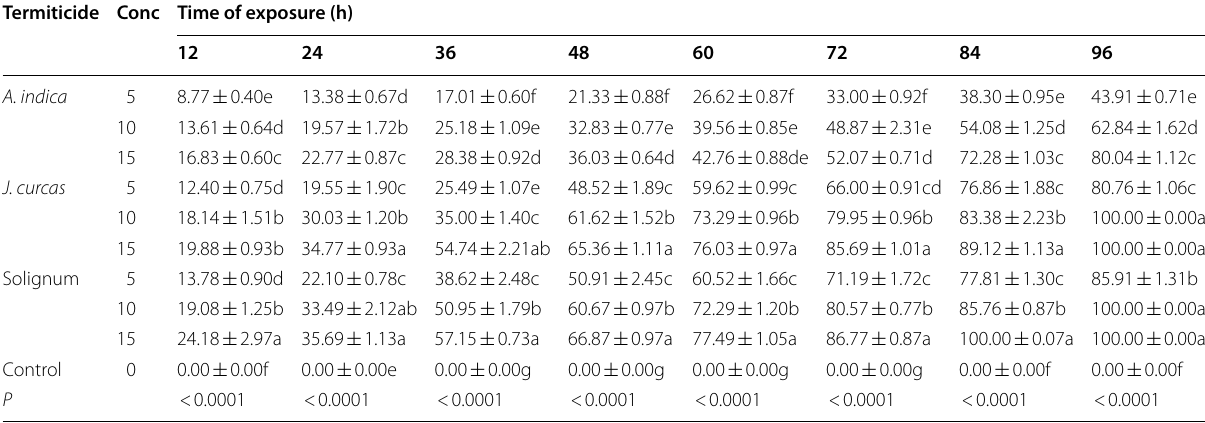
Data (%) were transformed (arcsine) before the analysis of variance; Means ( in a column are not significantly different from each other (DNMRT: P > 0.05); b concentration (mL/ 100 m 3 of wood surface); P